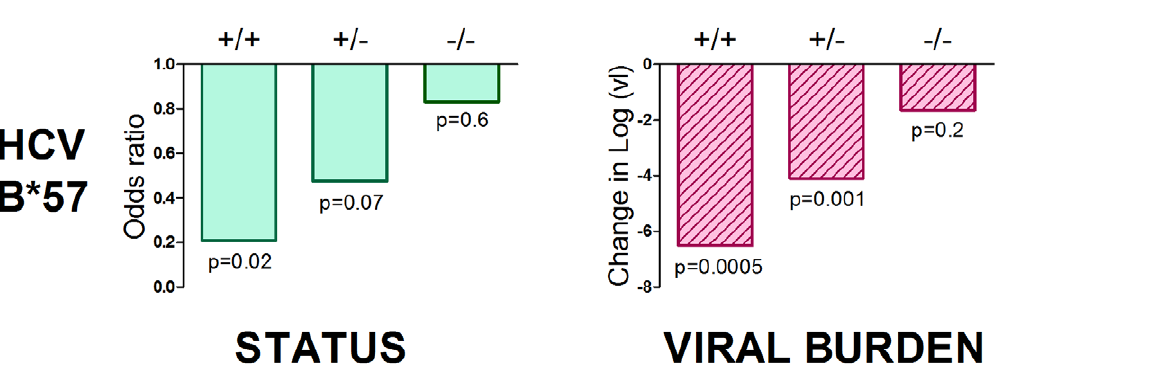
Figure 1. KIR2DL2 enhances HLA class I mediated antiviral-immunity. The effect of both protective (Figure 1a) and detrimental (Figure 1b) HLA class I alleles on both status (first column) and viral load (second column) is stronger in KIR2DL2 + individuals than in KIR2DL2- individuals. This effect was seen in both HTLV-1 and HCV infection. We also saw a progressive effect of KIR2DL2 copy number on both status and viral load in HCV